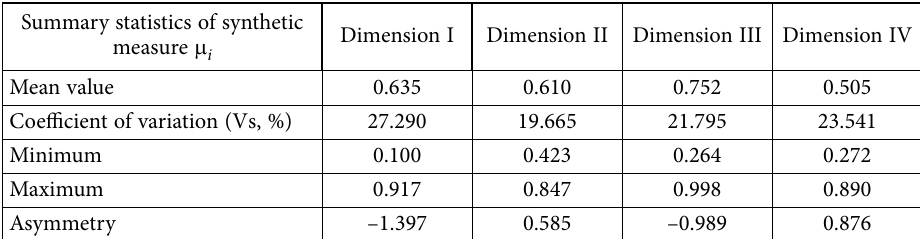
Table 8. Descriptive characteristics of the taxonomic measures in the dimensions of green economy and in